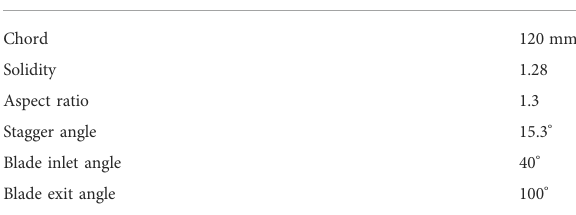
TABLE 2 Compressor cascade geometry and inlet aerodynamic parameters documented by Loughery et al.